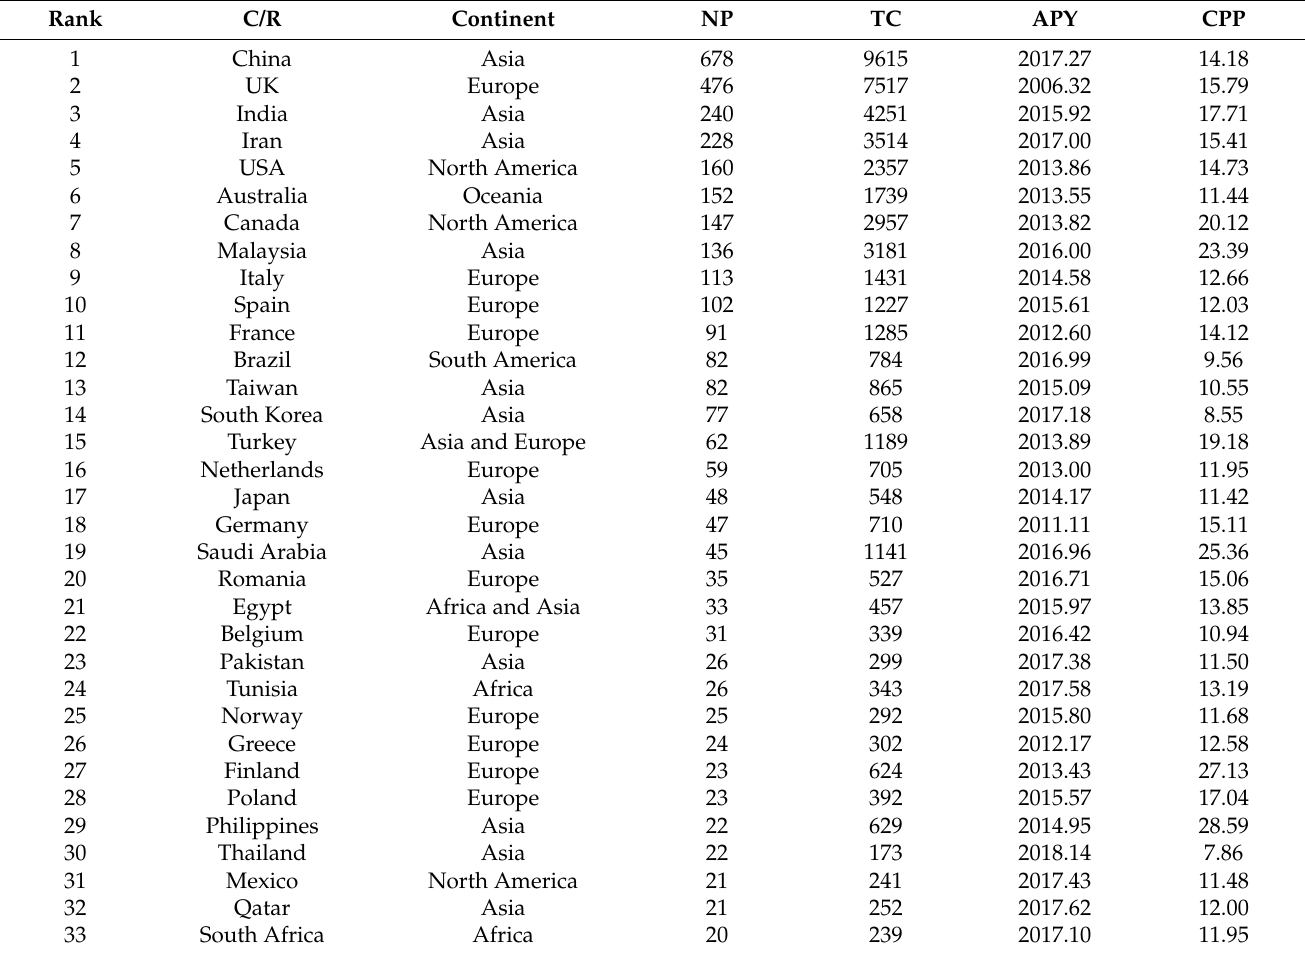
Table 3. Leading countries/regions in PSEP based on the number of publications (minimum number of publications = 20). Rank